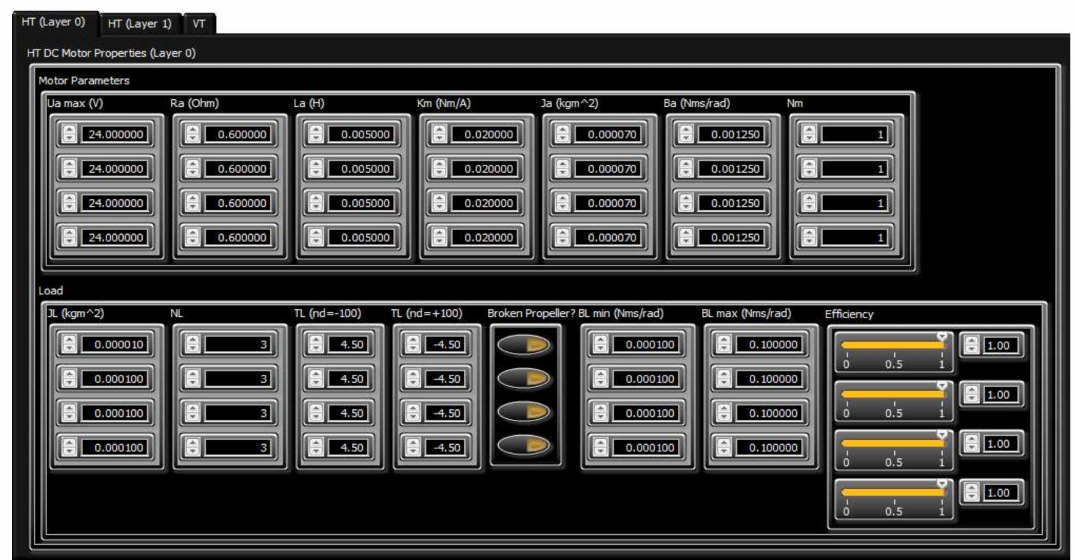
Figure 21. Thruster Configuration tab for horizontal thrusters (Layer 0) in the ROV dynamics simulator.